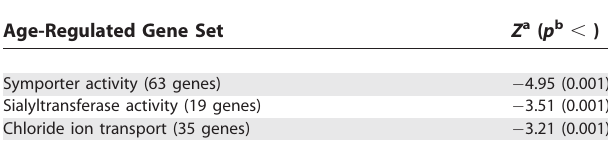
Table 2. Age-Regulated Gene Sets in Muscle Age-Regulated Gene